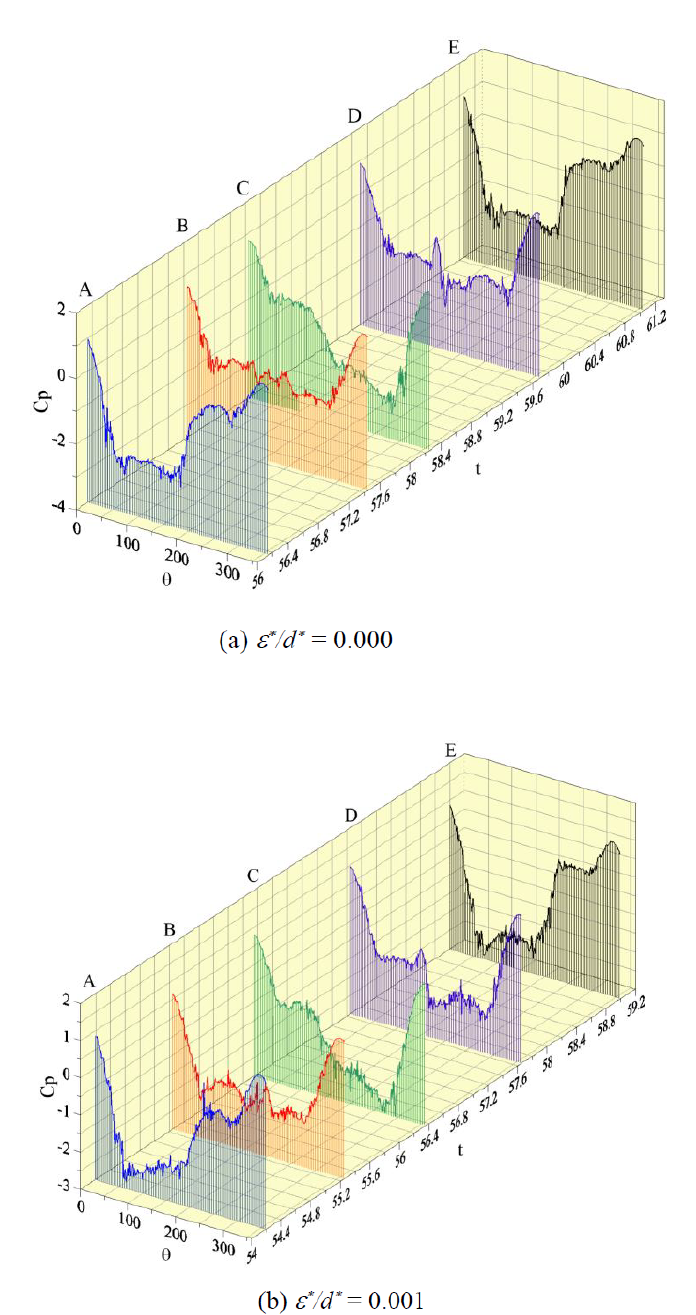
Figure 6. Instantaneous pressure distributions for the circular cylinder in the vicinity of a moving wall at h */ d * = 0.50 ( Re = 1.0 × 10 5 ).